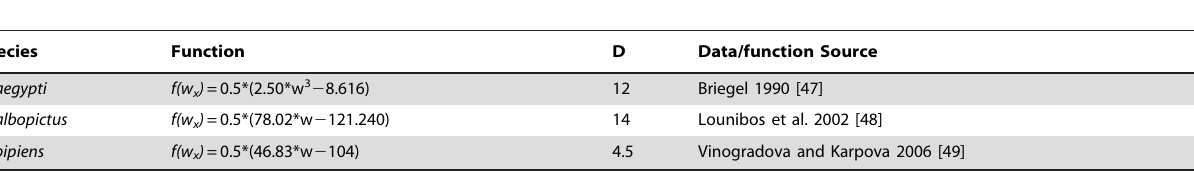
Table 1. Wing length-fecundity functions f(w x ) and D values for the three mosquito species, and the studies from which these values and functions were